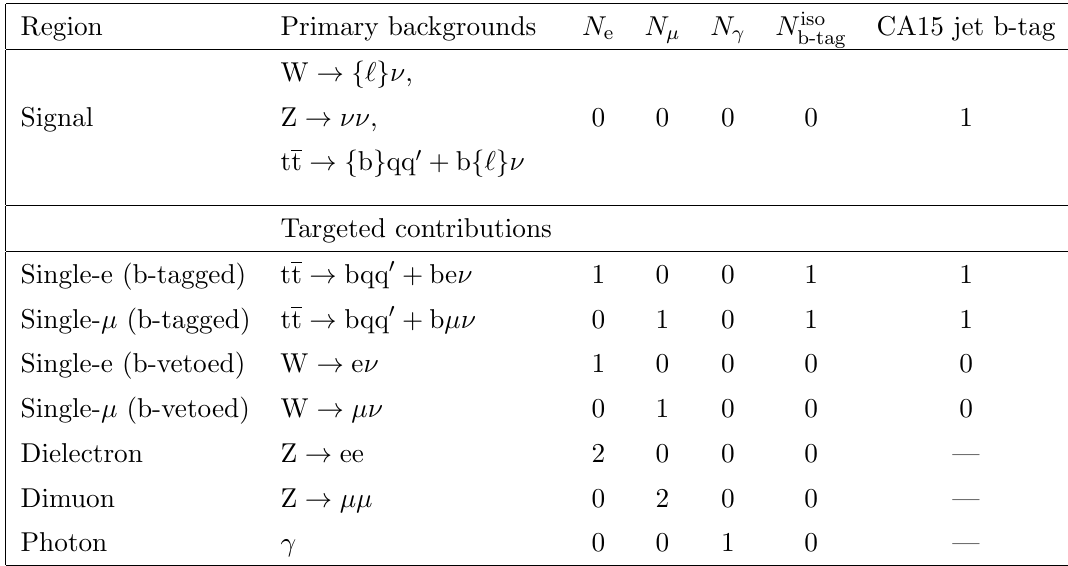
b and ‘ refer f g f g